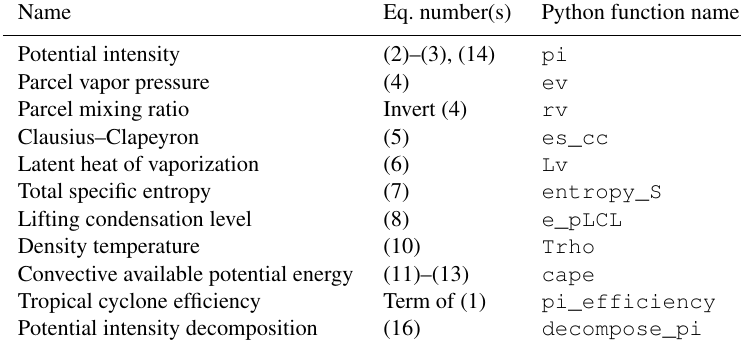
Table B1. Python functions to compute or analyze the potential intensity